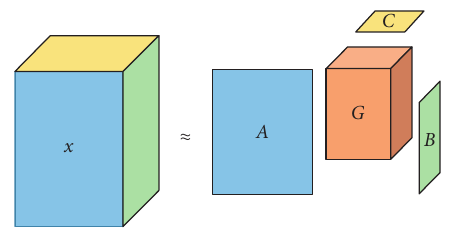
Figure 6: Illumination of three-way Tucker